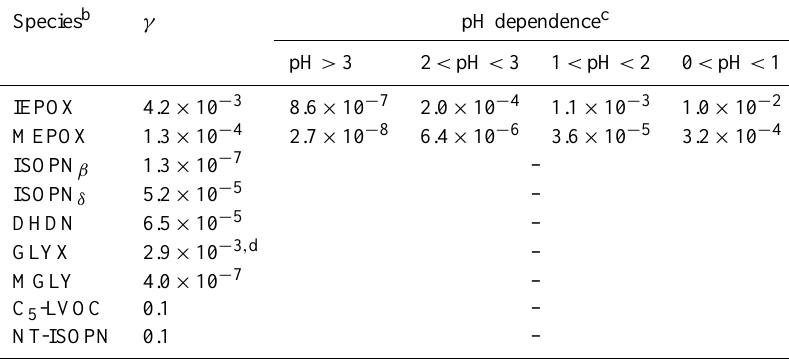
Table 2. Mean reactive uptake coefficients γ of isoprene SOA precursors a